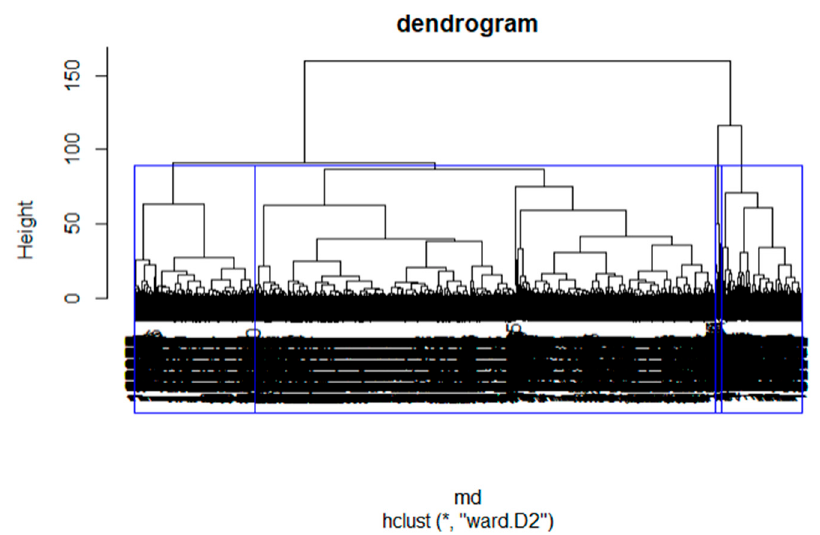
Figure A3. Dendrogram resulting from the distance matrix (dist.dudi function from ade4 R Package) calculated with Ward’s method. The four retained clusters are highlighted by the blue lines.